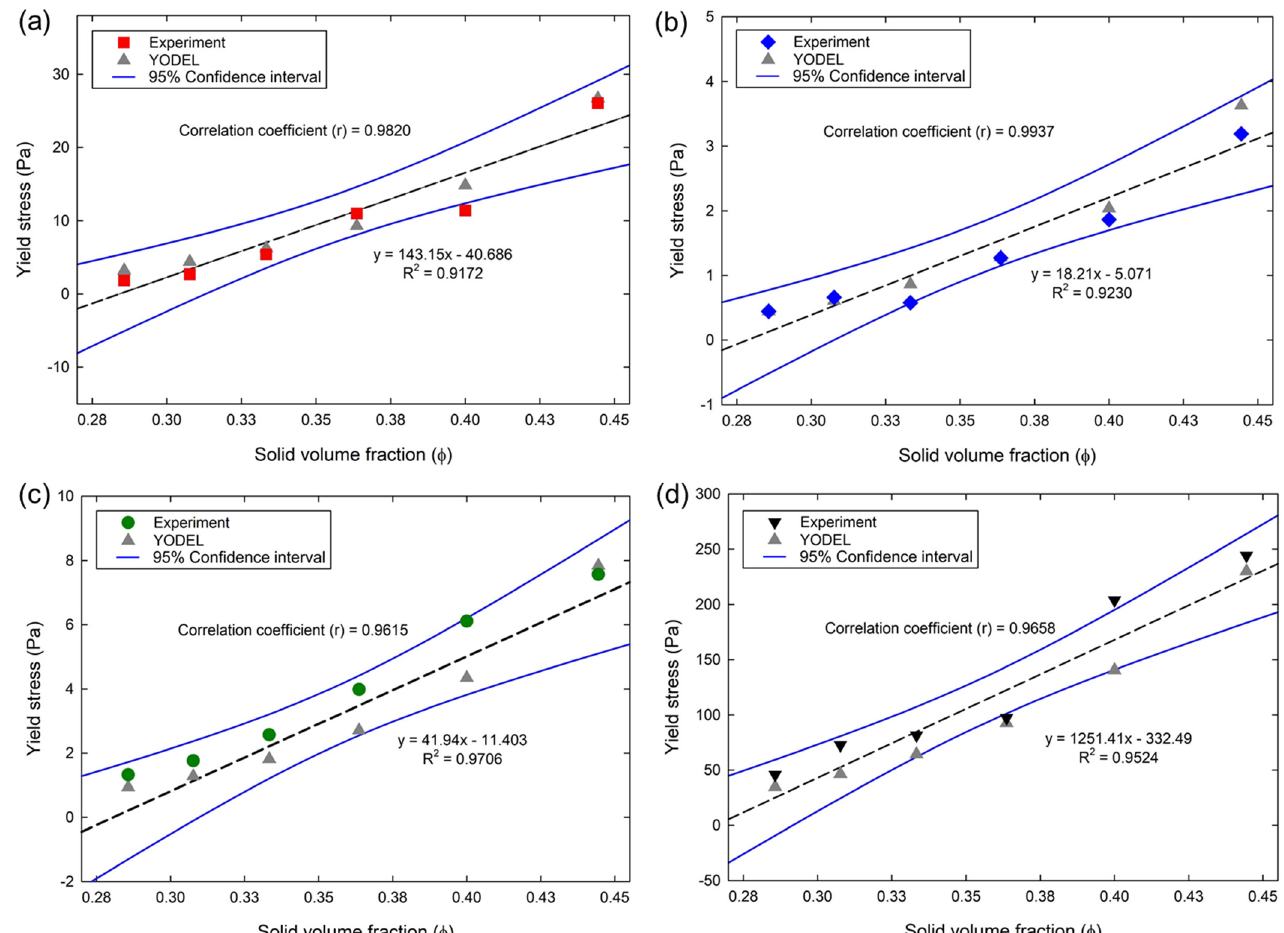
Figure 6. Yield stress of cementitious suspensions in YODEL predictions and experiments: ( a ) PC; ( b ) FA; ( c ) BS; ( d ) SF.